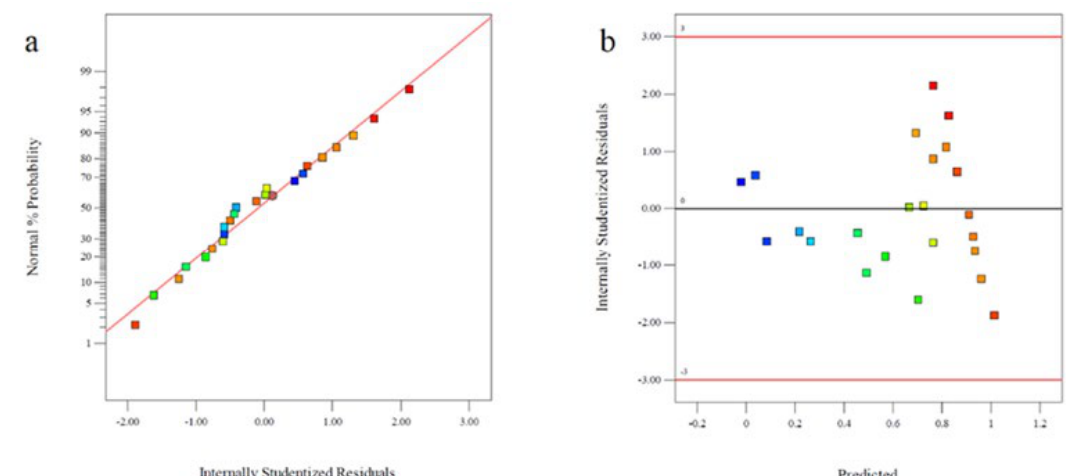
Fig. 3. Normal probability plot of residuals (a) and internally studentized residual versus the predicted plot (b) for PL intensity